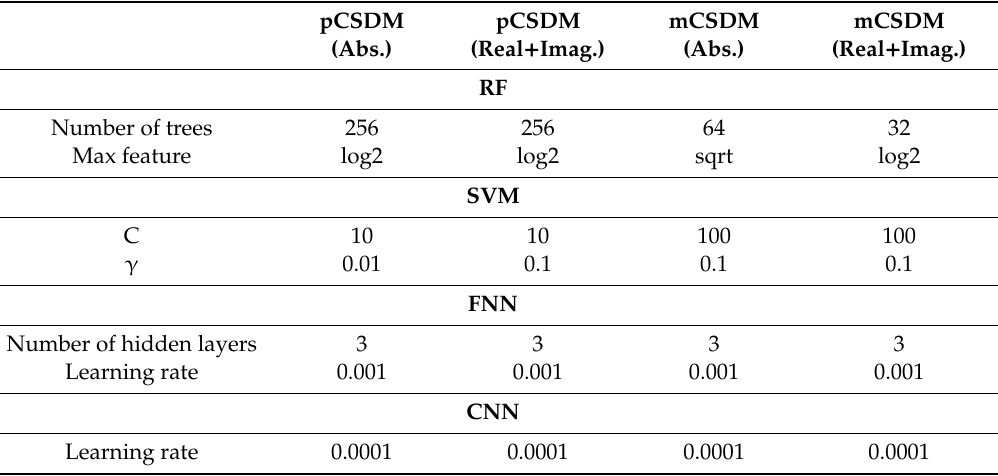
Table 1. Hyperparameters used in four machine learning